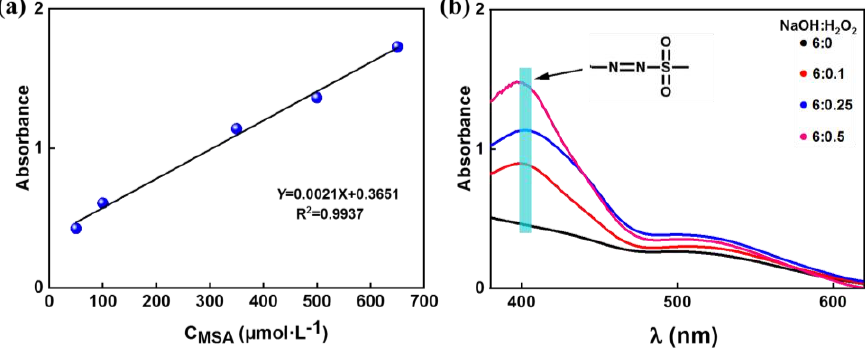
Figure 5. ( a ) The standard curve of C (MSA) and ( b ) absorbance curve of diazo derivatives.